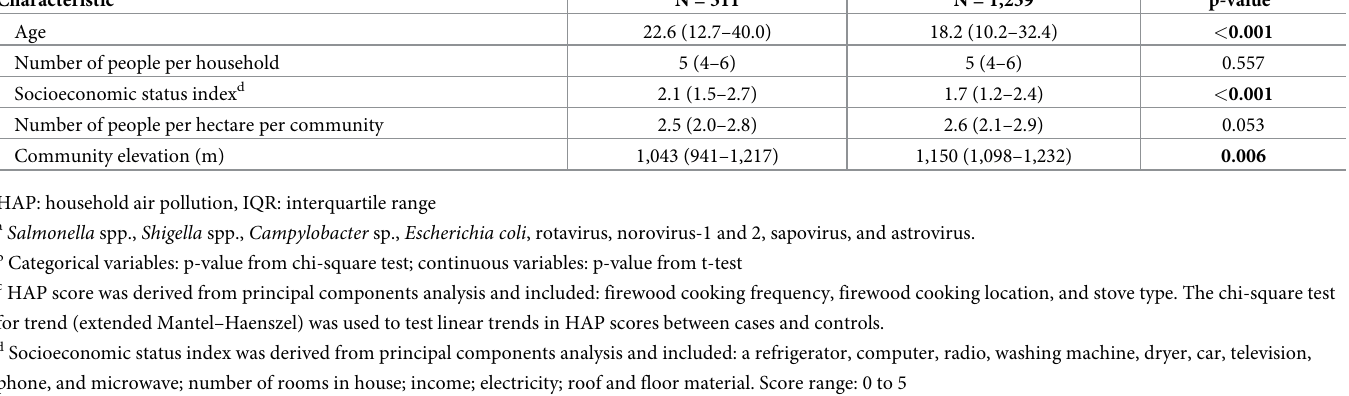
with firewood on an open hearth (AOR: 0.50; 95% CI: 0.33–0.78), even after adjusting for rele- vant covariates (Table 3). Tolerance values for all independent variables were above 0.90,